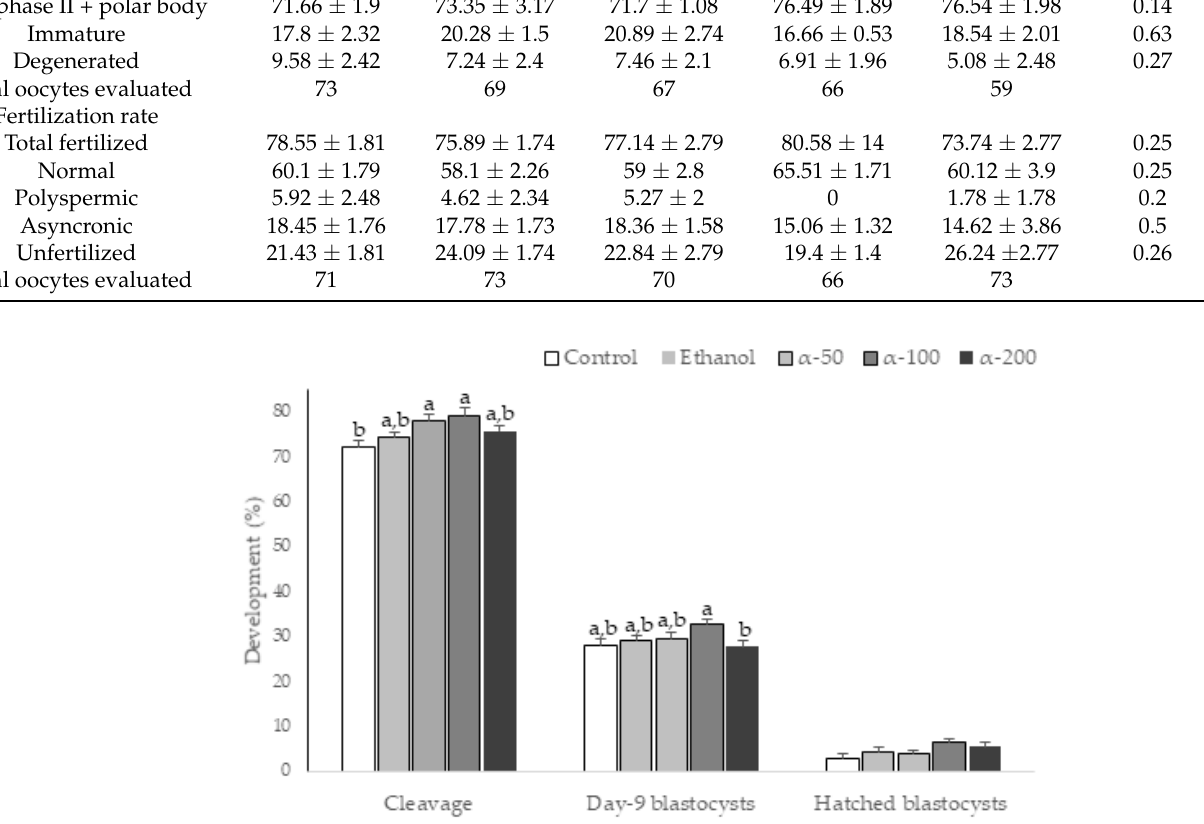
Figure 2. Effect of different α -tocopherol concentrations during bovine oocyte in vitro maturation on cleavage, blastocyst and hatching rates. Control: 0% ethanol and 0,0 α -tocopherol; Ethanol: 0.05% ethanol and 0,0 α -tocopherol; α -50: 50 μ M α -tocopherol; α -100: 100 μ M α -tocopherol; α -200: 200 μ M α -tocopherol. Different letters above each bar represent significant difference ( p < 0.05).